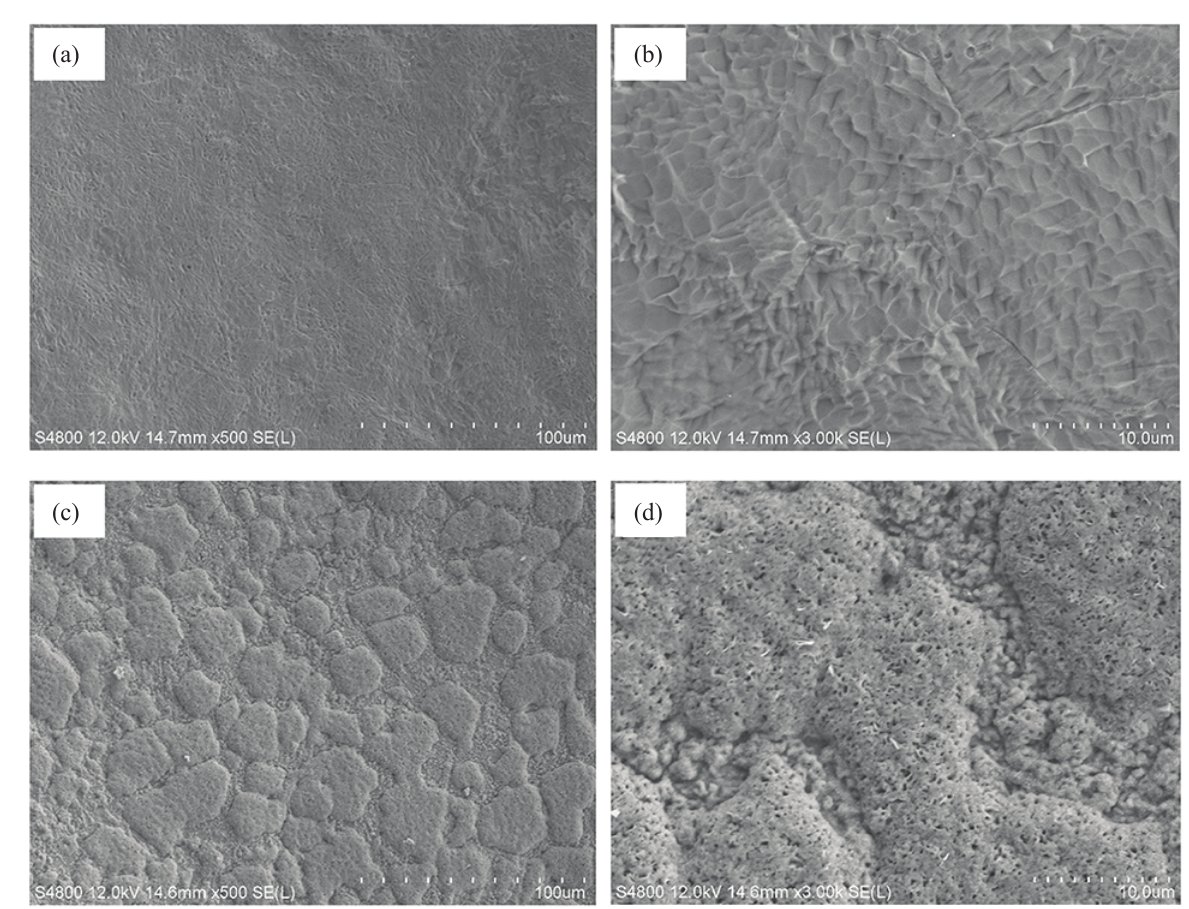
Fig. 3 – SEM images of catalyst plates: (a) before pretreatment (x500), (b) before pretreatment (x3,000), (c) after thermal pretreatment (x500), and (d) after thermal pretreatment